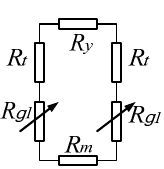
Figure 5. The equivalent magnetic circuit of the linear part.